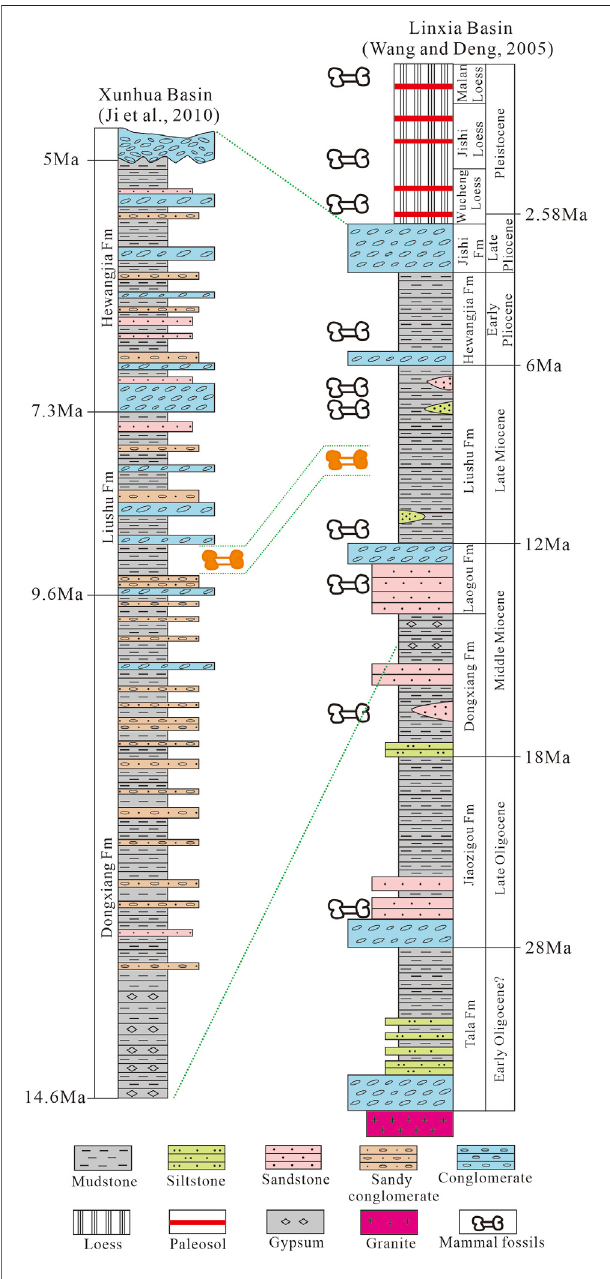
FIGURE 6 | Correlation of stratigraphic columns for the Xunhua and Linxia basins. Sources: Xunhua Basin (Ji et al., 2010), Linxia Basin (Wang and Deng,